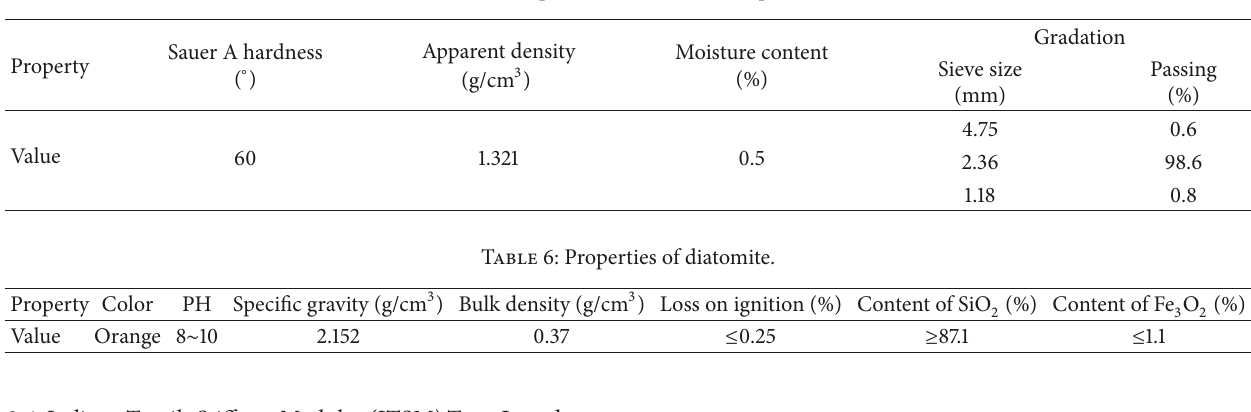
Table 5: Properties of crumb rubber particle.